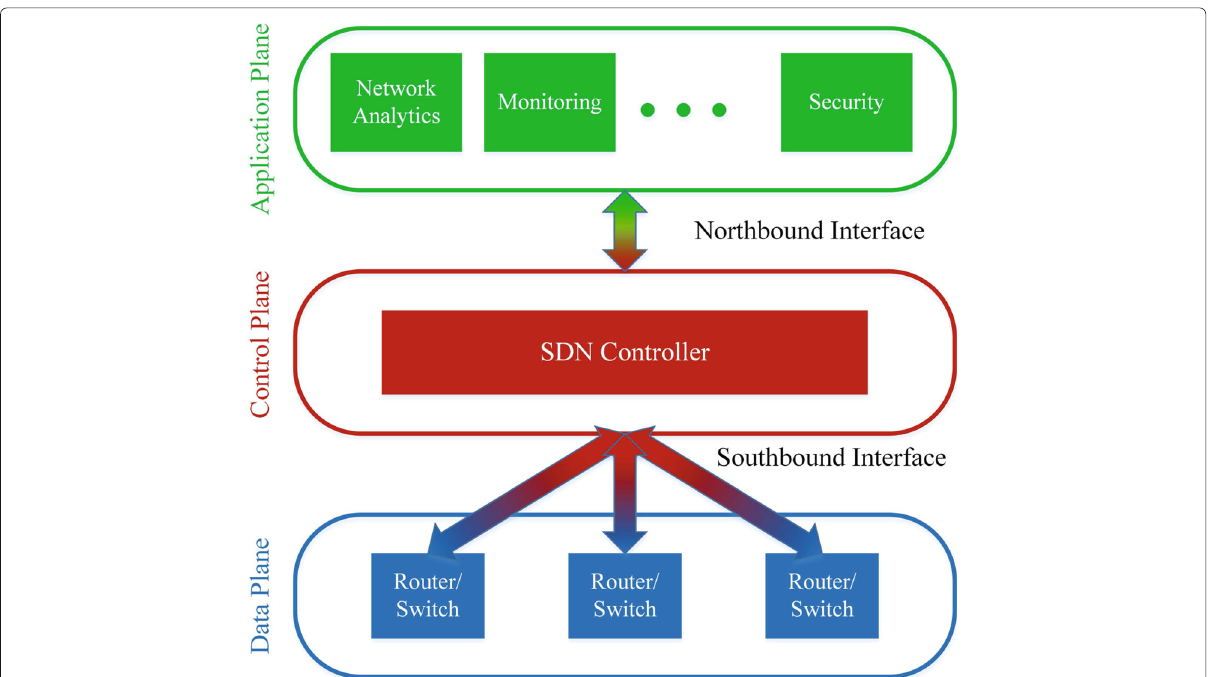
Fig. 1 SDN architecture in a three-layer